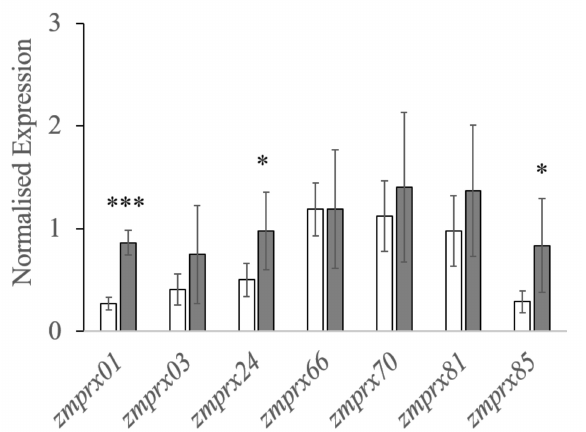
Figure 5. Expression profiles of class III peroxidases identified in the plasma membrane of maize roots. Total RNAs of non-stressed (white columns) and 24 h hypoxia-stressed roots (gray columns) were extracted for gene expression analyses (RT-qPCR) with SYBRGreen. Expression was